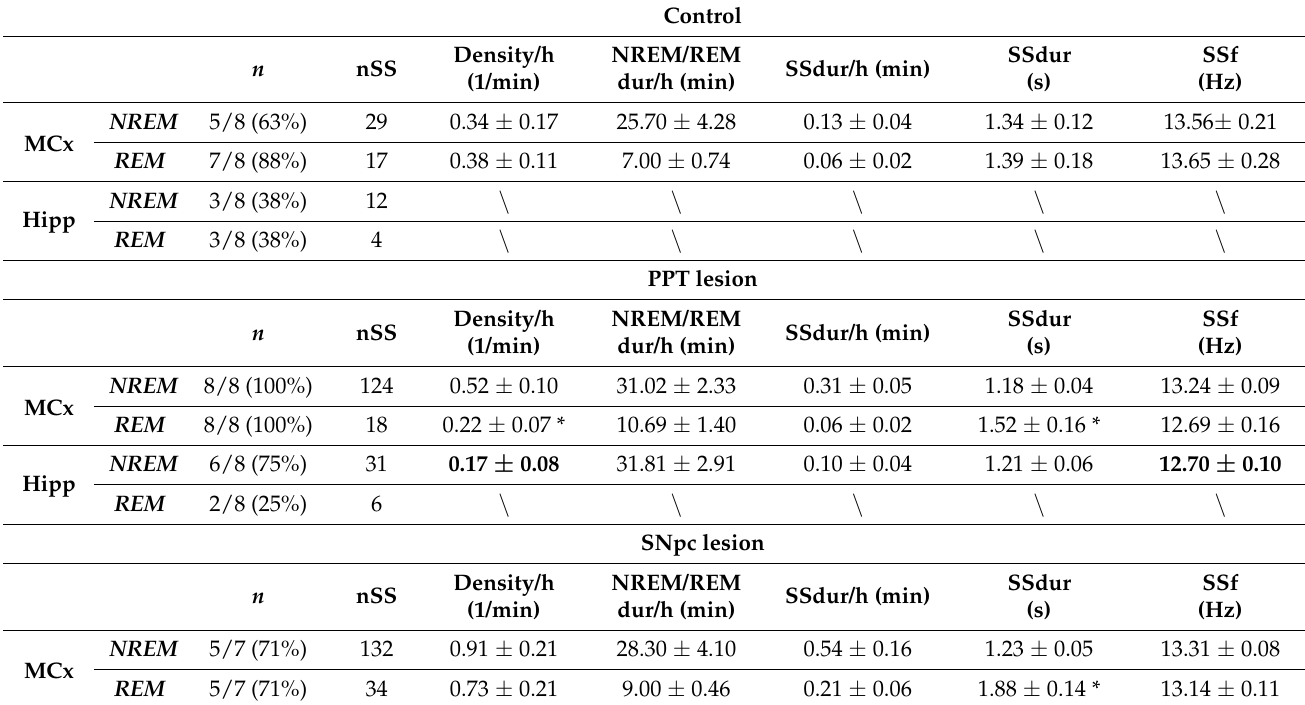
Table 1. Sleep spindles (SS) dynamic during NREM and REM sleep in the distinct rat models of PD.